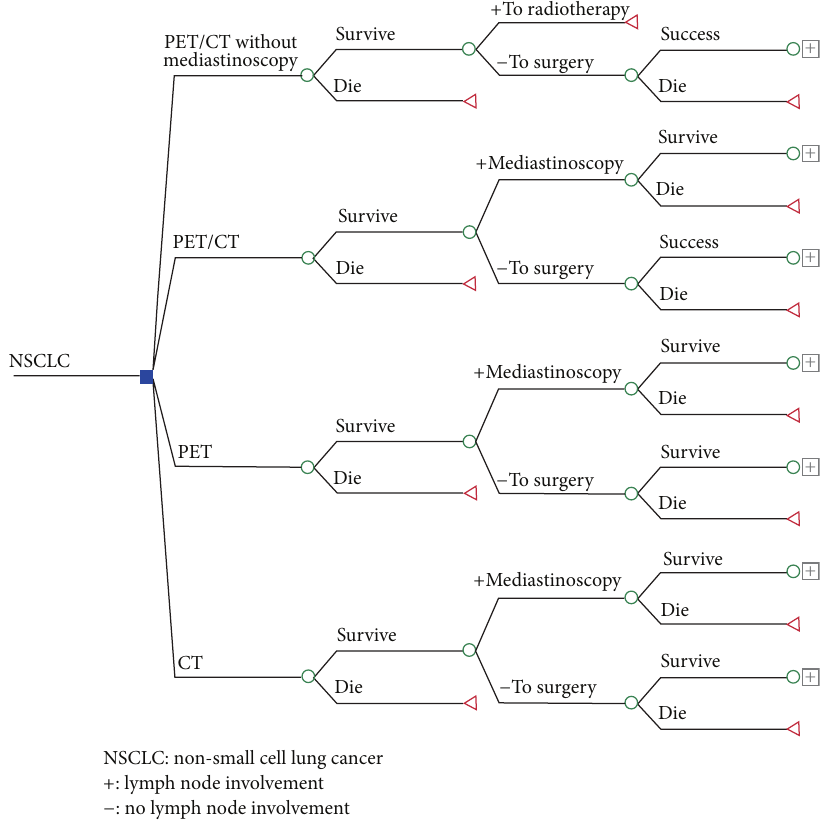
Figure 1: Structure of the decision tree for assessing the cost-effectiveness of the different staging alternatives examined.